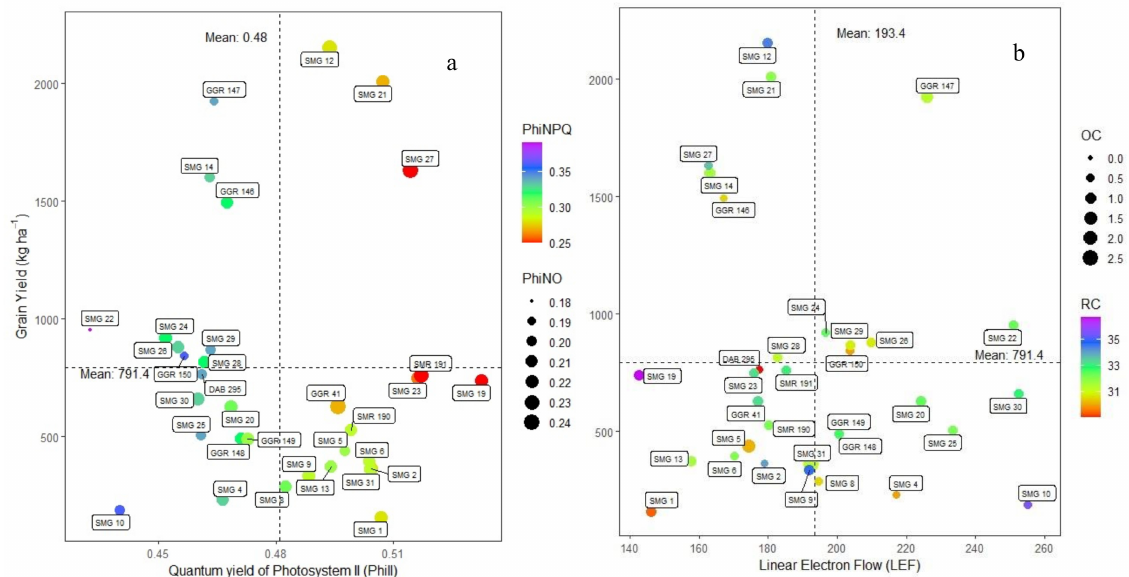
Figure 2. Relationship between grain yield (GY) and different variables related to the functioning of the photosynthetic apparatus. ( a ) Grain yield and quantum yield of photosystem II ( Φ II) as a function of the gradient of non-photochemical quenching Φ NPQ (change in the colour of violet and red as greater to lesser value) and magnitude of non-regulated processes Φ NO (size of the circle), parameters that affect the response variable. ( b ) Grain yield and linear electron flow (LEF) as a function of the gradient of PSI Over Reduce Center PSIor (change in the colour of violet and red as greater to lesser value) and magnitude of PSI Open Center PSIopen (size of the circle), parameters that affect the response variable. The dotted lines on the axes correspond to the means of the dependent and independent